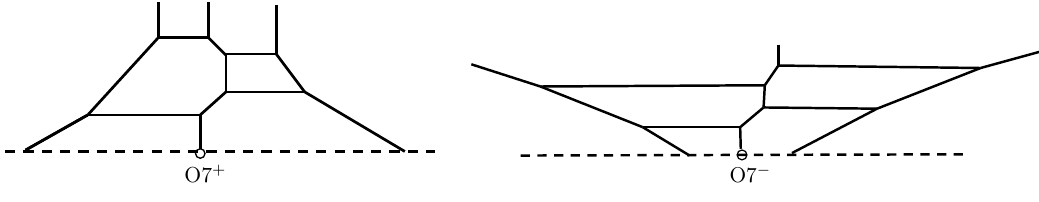
Figure 1 . (Left-panel) SU(4) gauge theory with a symmetric hypermultiplet. (Right-panel) SU(4) gauge theory with an anti-symmetric